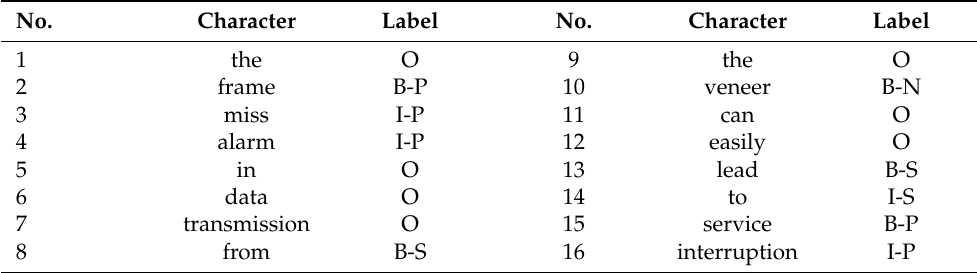
Table 4. Training Set Corpus Sample Labeling Example